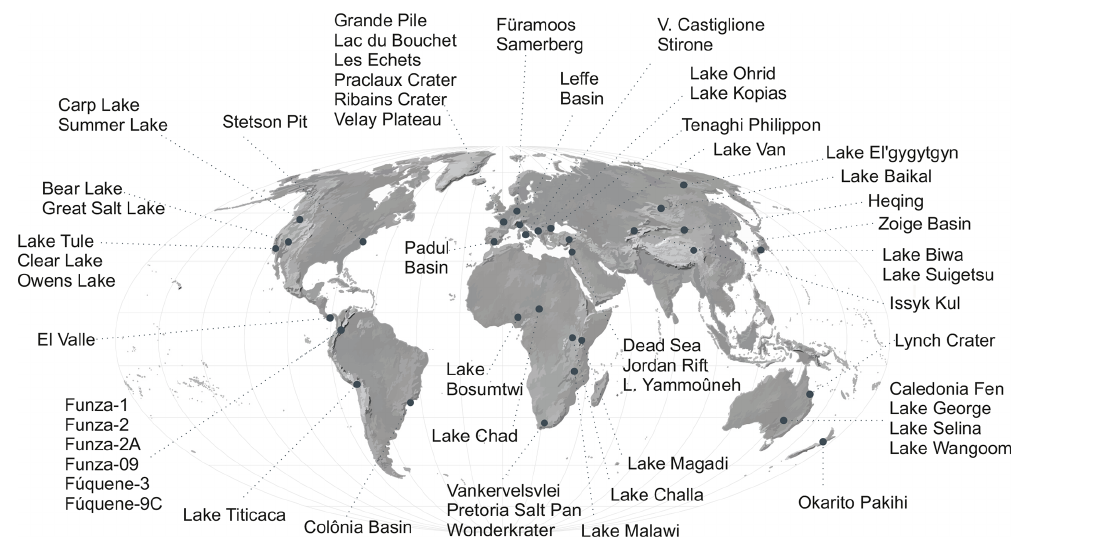
Figure 1. Global compilation of long continental fossil pollen records ( > 125ka). See also Table S1.